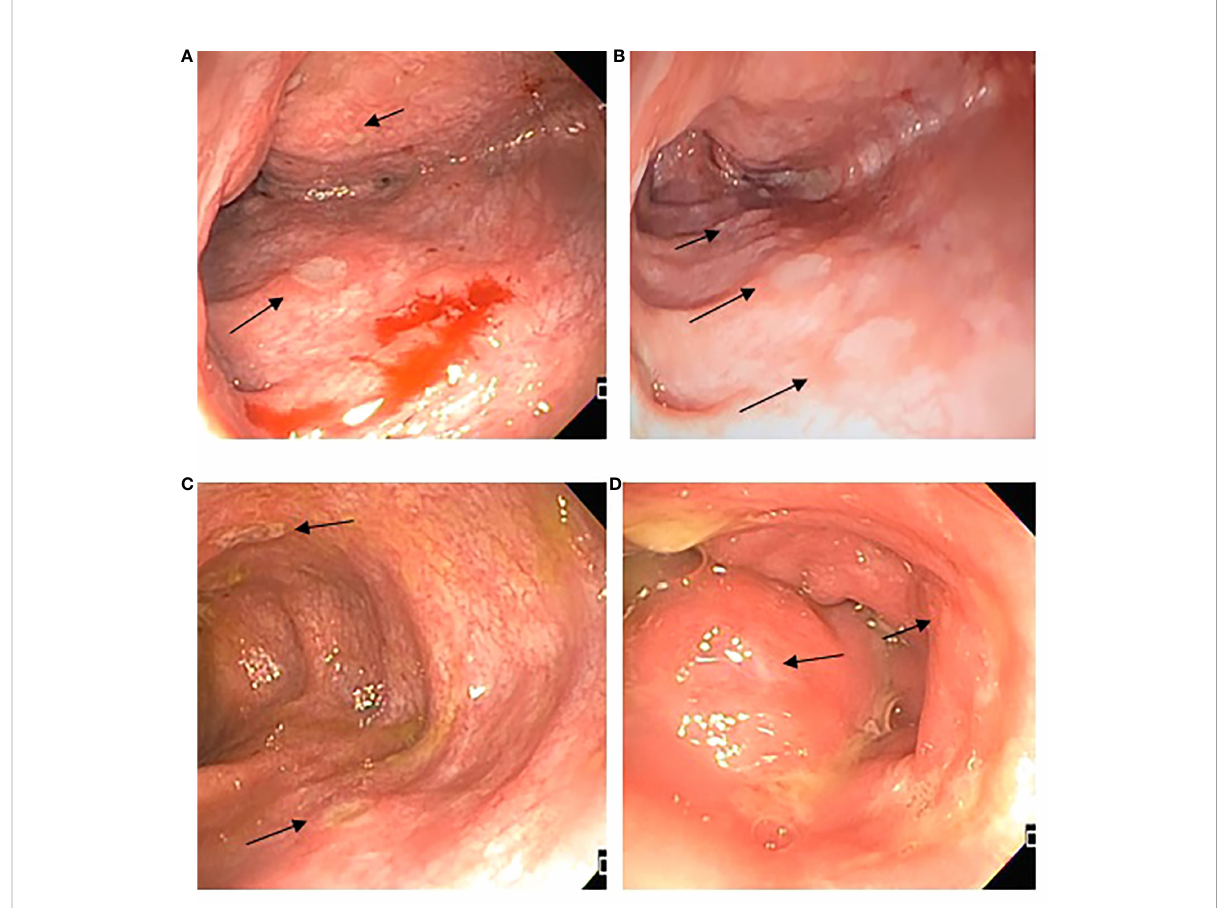
FIGURE 2 Endoscopic features. (A) Ascending colon with edema, erythema, and multiple fi brin-covered ulcers, different sizes between 1 and 5 mm, friability; (B) Transverse colon with multiple fi brin-covered ulcers of 3 mm, patchy obliteration of vascular pattern; (C) Descending colon presence of deeper ulcers, with mild raise edge; (D) Rectum super fi cial small ulcers